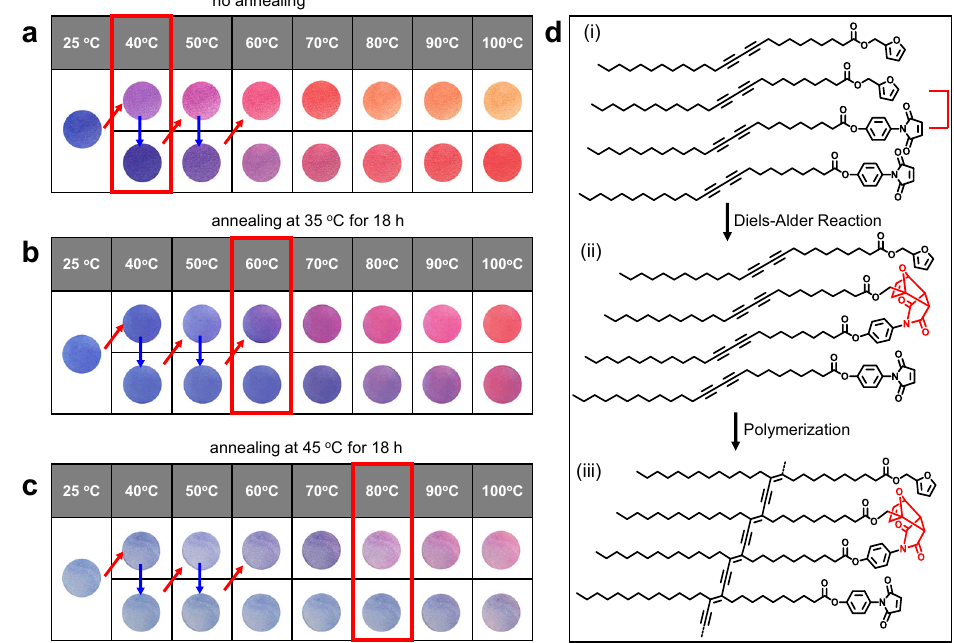
Fig. 8 Thermochromic reversibility assessment of the retro Diels – Alder (rDA)-derived polydiacetylene (PDA) with thermal annealing. a – c Photographs of heat-treated (110 °C, 5 min) and UV irradiated (254 nm, 1 mW cm − 2 , 1 min) 1-endo-coated fi lter papers upon thermal cycling. Polymerization was conducted without thermal annealing ( a ), after thermal annealing at 35 °C ( b ) and 45 °C ( c ) for 18 h. d Schematic representation of Diels-Alder (DA) adduct formation between furan and maleimide in the PDA. The diacetylenic furan and maleimide form a self-assembled structure (i) and undergo the Diels – Alder reaction to produce DA adducts in the supramolecular architecture during the annealing process (ii). UV-induced polymerization leads to the formation of a PDA that contains DA adducts